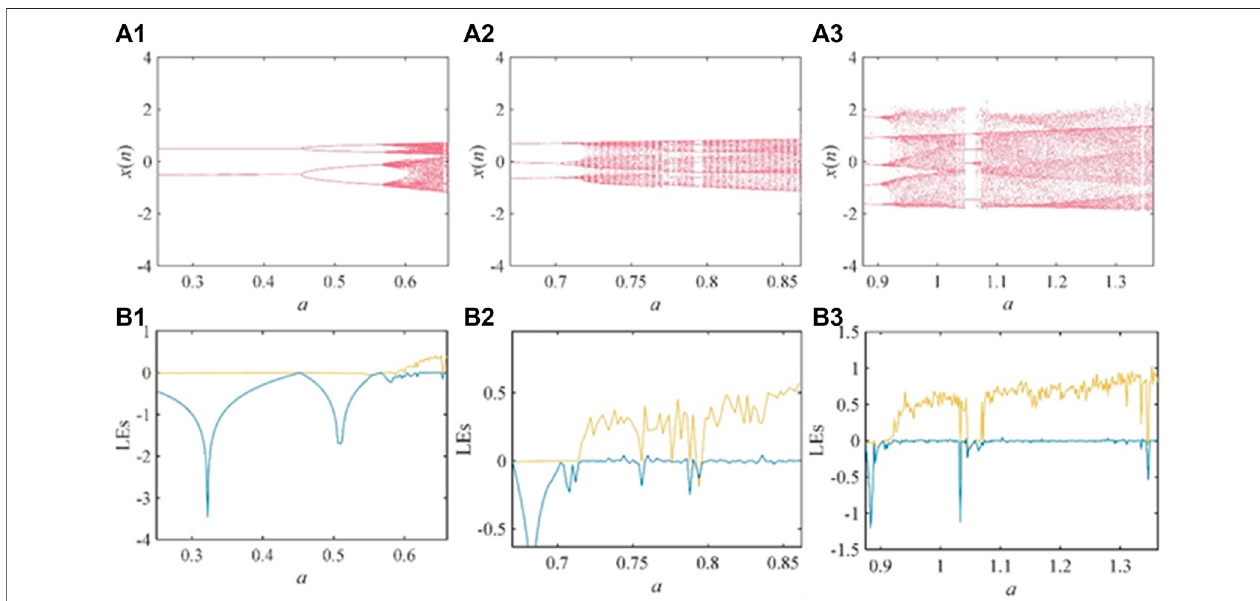
FIGURE3| BifurcationandLEsofthemapwithparameter a . (A1) a ϵ (0.25,0.66); (A2) a ϵ (0.67,0.862); (A3) a ϵ (0.875,1.363); (B1) a ϵ (0.25,0.66); (B2) a ϵ (0.67, 0.862); (B3) a ϵ (0.875, 1.363).